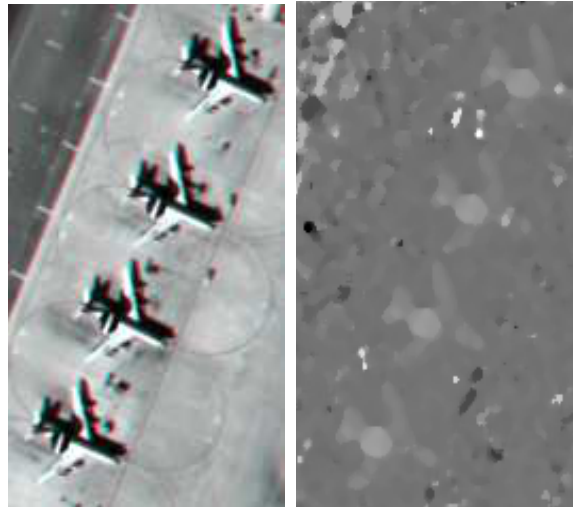
Figure 20 : Awacs airplanes 3D rendering : anaglyph and DEM.